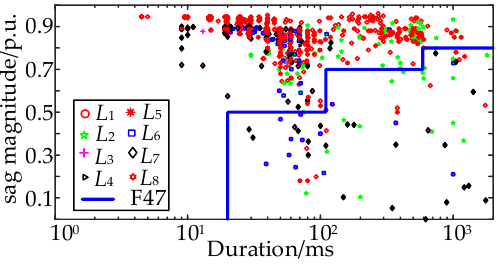
Figure 14. Scatter plot of the measured voltage sags of L 1 ~ L 8 and the SEMI F47 characteristic.